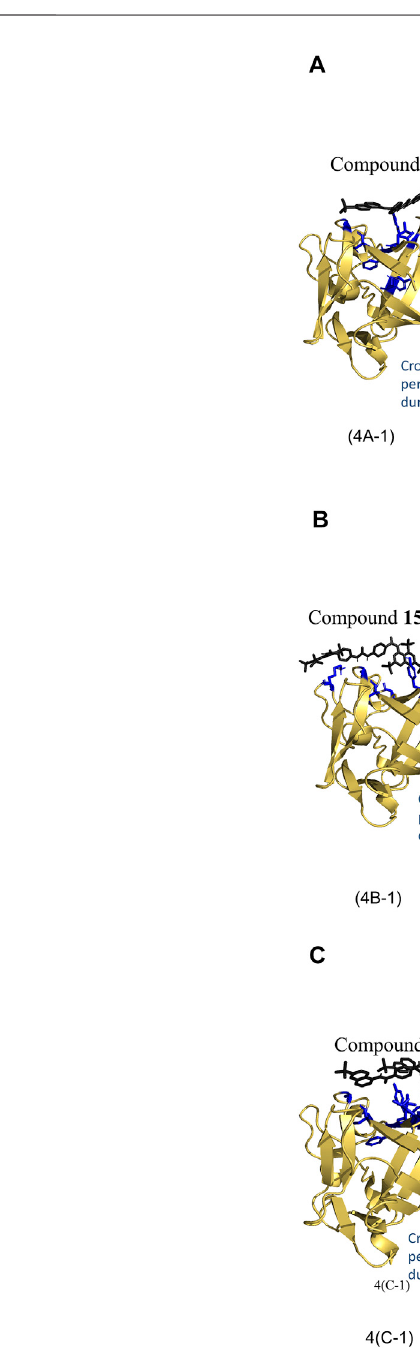
Frontiers in Chemistry |